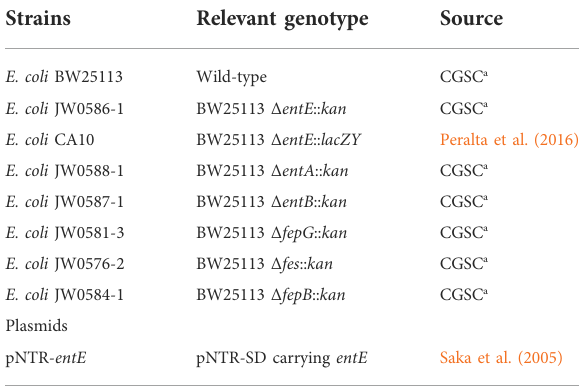
TABLE 1 List of strains and plasmids used in this